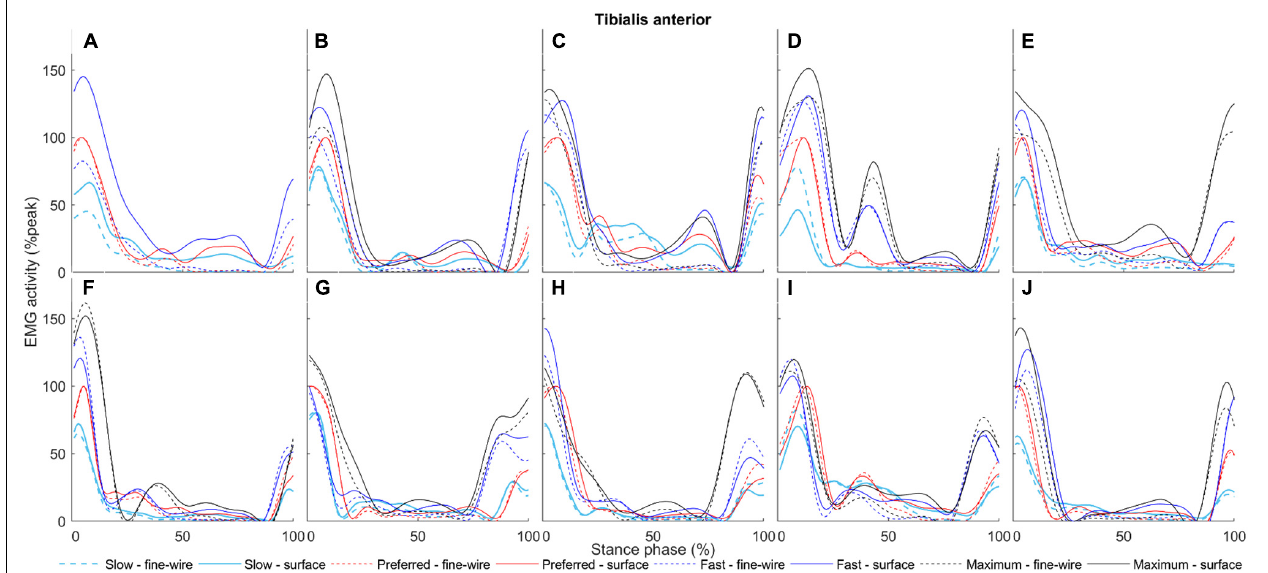
FIGURE 11 | Tibialis anterior surface (solid) and intramuscular (dashed) electromyography (EMG) activity at slow, preferred, fast, and maximum walking speeds (1.01 ± 0.13, 1.43 ± 0.19, 1.84 ± 0.23, and 2.20 ± 0.38 m s − 1 , respectively) in the stance phase for each individual ( A–J , respectively). The amplitudes of smoothed and time-normalised EMG curves were normalised to peak activity in preferred speed walking (%peak). Each curve represents the average of all steps (number of steps included in the analysis were 14 ± 3, 12 ± 3, 11 ± 2, and 9 ± 1, median ± interquartile range, at slow, preferred, fast, and maximum walking speeds, respectively) at a given walking